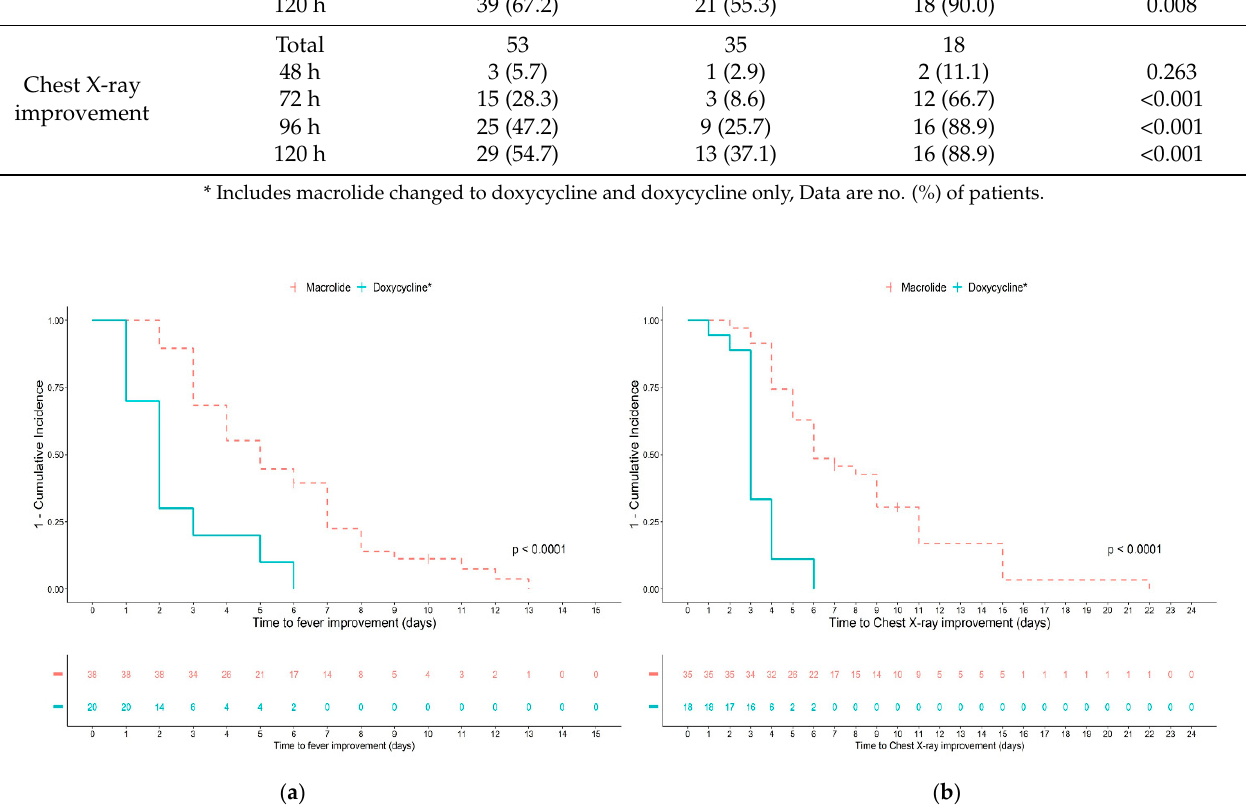
Figure 2. Cumulative incidence analysis of fever and chest X-ray improvement according to antibiotic group in children with macrolide-resistant Mycoplasma pneumoniae pneumonia. ( a ) Time to resolution of fever; ( b ) time to chest X-ray improvement in children treated with macrolides only or doxycycline (* including macrolides changed to doxycycline and doxycycline only).